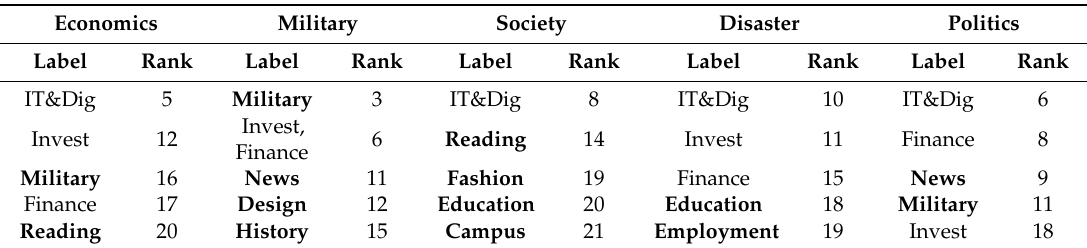
Table 1. Label frequency for the different rumor refuters.